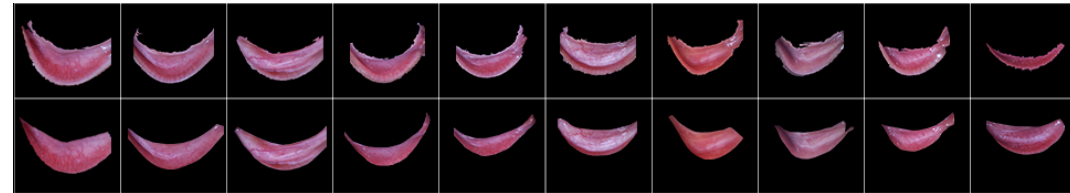
Figure 8. The top row represents a subset of samples automatically segmented with the proposed approach. The ordered second row depicts the mapping with the manual segmentation ground truth of the conjunctival region.